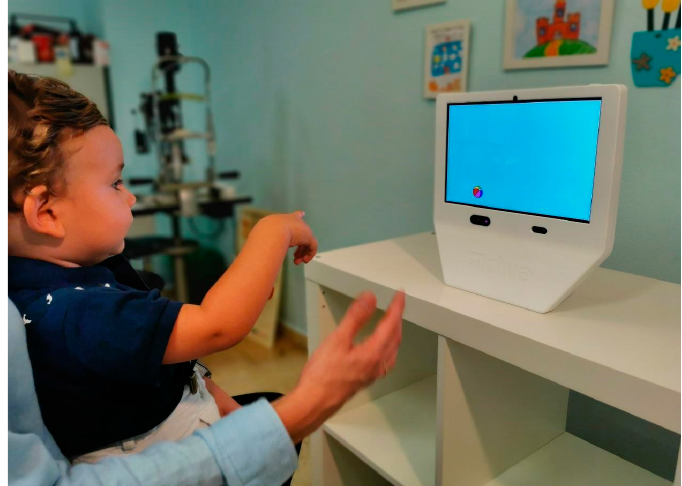
Figure 1. A child performing the calibration process of DIVE. After that, the test shows four circles with different luminance, against a plain grey background. One of the circles has a pattern of stripes of a certain width or contrast (Figure 2). Following the principle of preferential looking, if the child is able to discriminate the stripes, he or she will fixate on the striped circle instead of the homogeneous greys. DIVE will offer positive feedback if the patient looks at the striped stimulus within three seconds, by showing a star in the centre of the circle and a reward sound. A correct answer will make the following trial more difficult to recognize, which means, in the VA test, narrower stripes in the patterned circle and, in the CS test, less contrast difference between the stripes. In case the child does not discriminate the pattern and looks at another circle, the next trial will be easier to recognise.